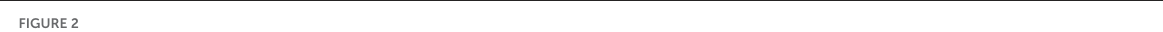
FIGURE2 infection (2) can lead to locoregional inflammation (2), as well as antiviral responses in the infected cell. Inflammation combined with antigen release can permit DC migration to lymph nodes (3), so while non-specific cells continue to recirculate through the tissue (4), new immune responses can be initiated in the draining lymph node (5). (ii) Following expansion of antiviral T cells in the draining lymph node, these cells can be preferentially recruited to the site of infection via the impact of inflammation on the vasculature (1). Chemokines released by infected cells can recruit T cells through the stroma to the infection site (2). Cognate recognition of infected cells (3) can lead to their death (4). Dying cells are actively cleared, which can initiate repair and shut down inflammation in the infection site (5). (B) (i) The immune response to cancer, either in early dysplasia or in a malignant tumor, can result in infiltration of tissue resident memory T cells (1), as well as stromal infiltration of T cells, though local immune suppression (2) results in tumor growth dominating over tumor destruction. Ongoing cancer cell death, due to hypoxia or limited growth factor availability can lead to antigen release (3), though stromal suppression can limit the quality of antigen presentation. T cells can continue to recirculate through tumors (4), though they may be restricted to the stroma and poorly interact with cancer cells, and stromal cells can support further invasion of the cancer into surrounding tissues (5). (ii) Immunotherapy with checkpoint inhibitors (1) may derepress local T cells or recirculating T cells to permit destruction of cancer cells. Inflammatory cytokines released by activated T cells can